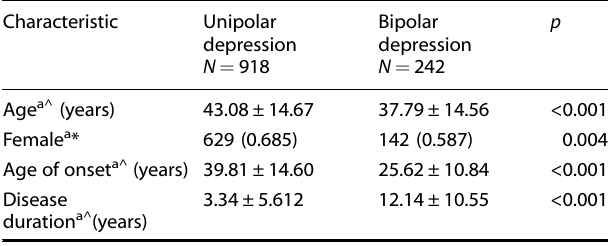
Table 1. Socio-demographic and clinical characteristics of samples